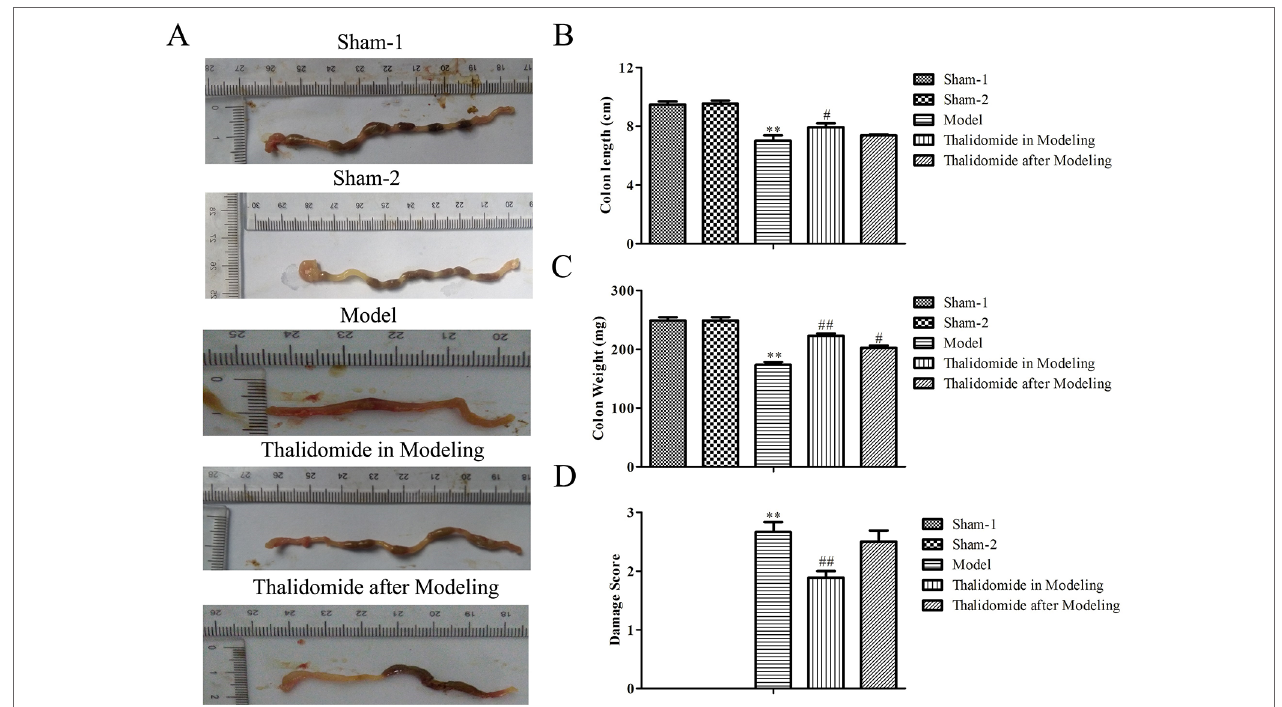
FIgURe 2 | Effects of thalidomide on the colonic weight and length in mice induced with TNBS. The colonic length and weight of mice from different groups were measured, and treatment with thalidomide showed remarkably effects in TNBS-induced alterations in colonic weight, length and macroscopic scores. The results were expressed as the mean ± SD. ** P < 0.01 compared with the sham-1 and sham-2 groups; # P < 0.05, ## P < 0.01 compared with the model group.